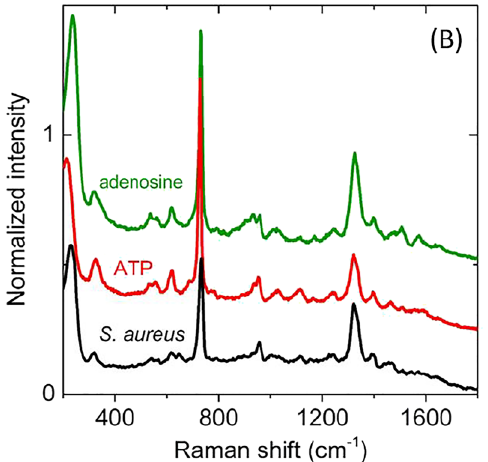
Figure 11: The Microwell-SERS system: (A) Schematic diagram of the system, including Raman microscopy and the Microwell-SERS device; (B) photo of the microwell device attached with a SERS substrate with the SERS-active surface (in purple) facing downward; (C) bright- fi eld image of the microwells rehydrated with blue food dye (scale bar, 200 μ m); (D) fl uo- rescence image of 106 CFU mL − 1 GFP-transfection bacteria con fi ned in nine microwells (scale bar, 50 μ m). Reprinted with permission from [58], Copyright © Royal Society of Chemistry 2017.